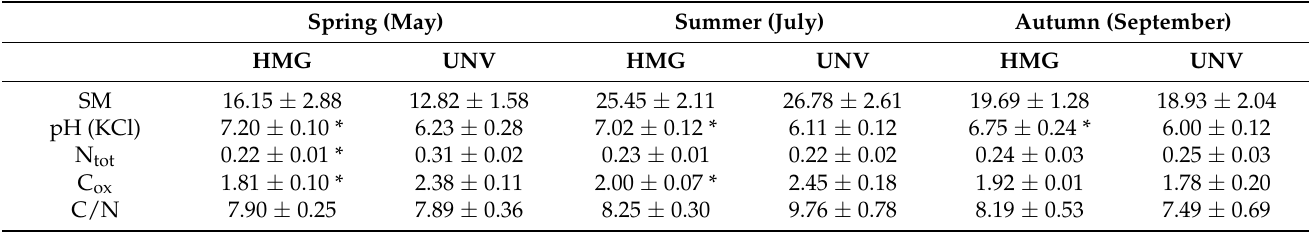
Different from uninvaded control according the Tukey’s (HSD) post-hoc test (* for p < 0.05) ( n = 10). HMG— Heracleum mantegazzianum invaded plots ; UNV—uninvaded control; SM—soil moisture (% of initial weight); pH (KCl)—soil acidity; N tot —soil nitrogen content (% of dry weight); C ox —soil carbon content (% of dry weight); C/N—ratio of carbon to